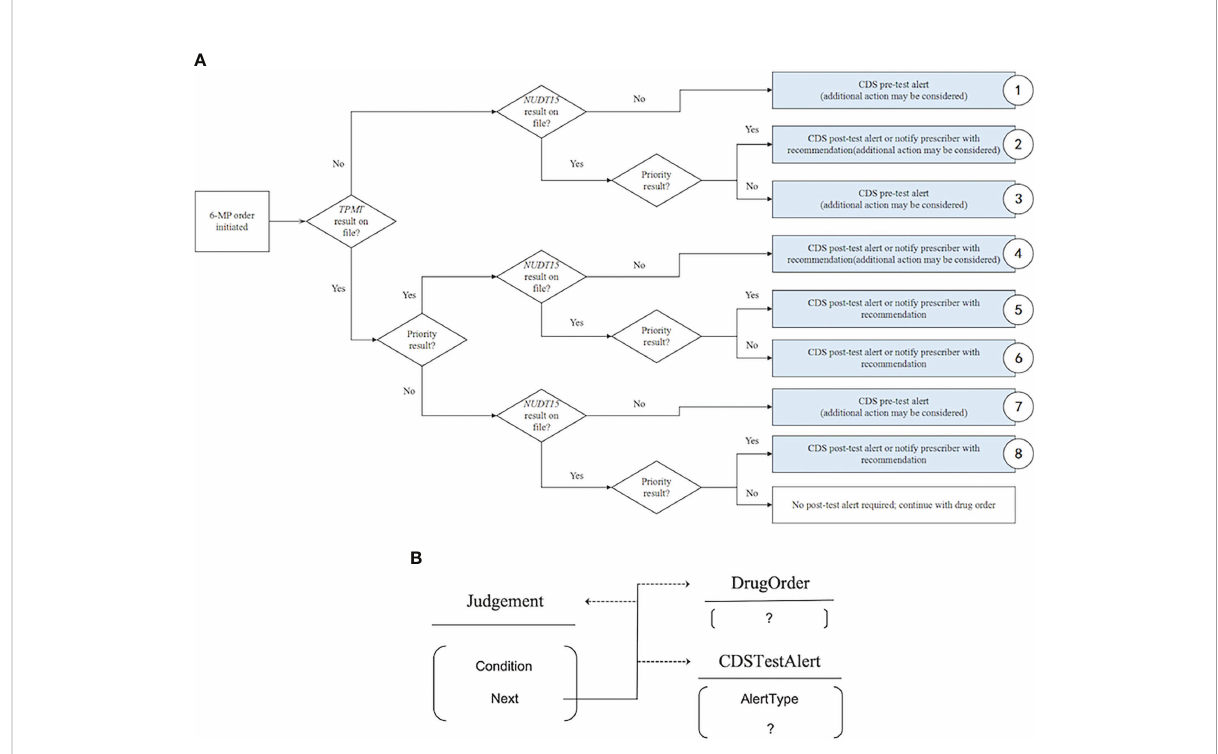
FIGURE 1 Decision fl ow in the CDS and its modelling. (A) The decision fl ow in dosing guidelines. (B) MMKP modelling of the decision fl ow using a polymorphic foreign